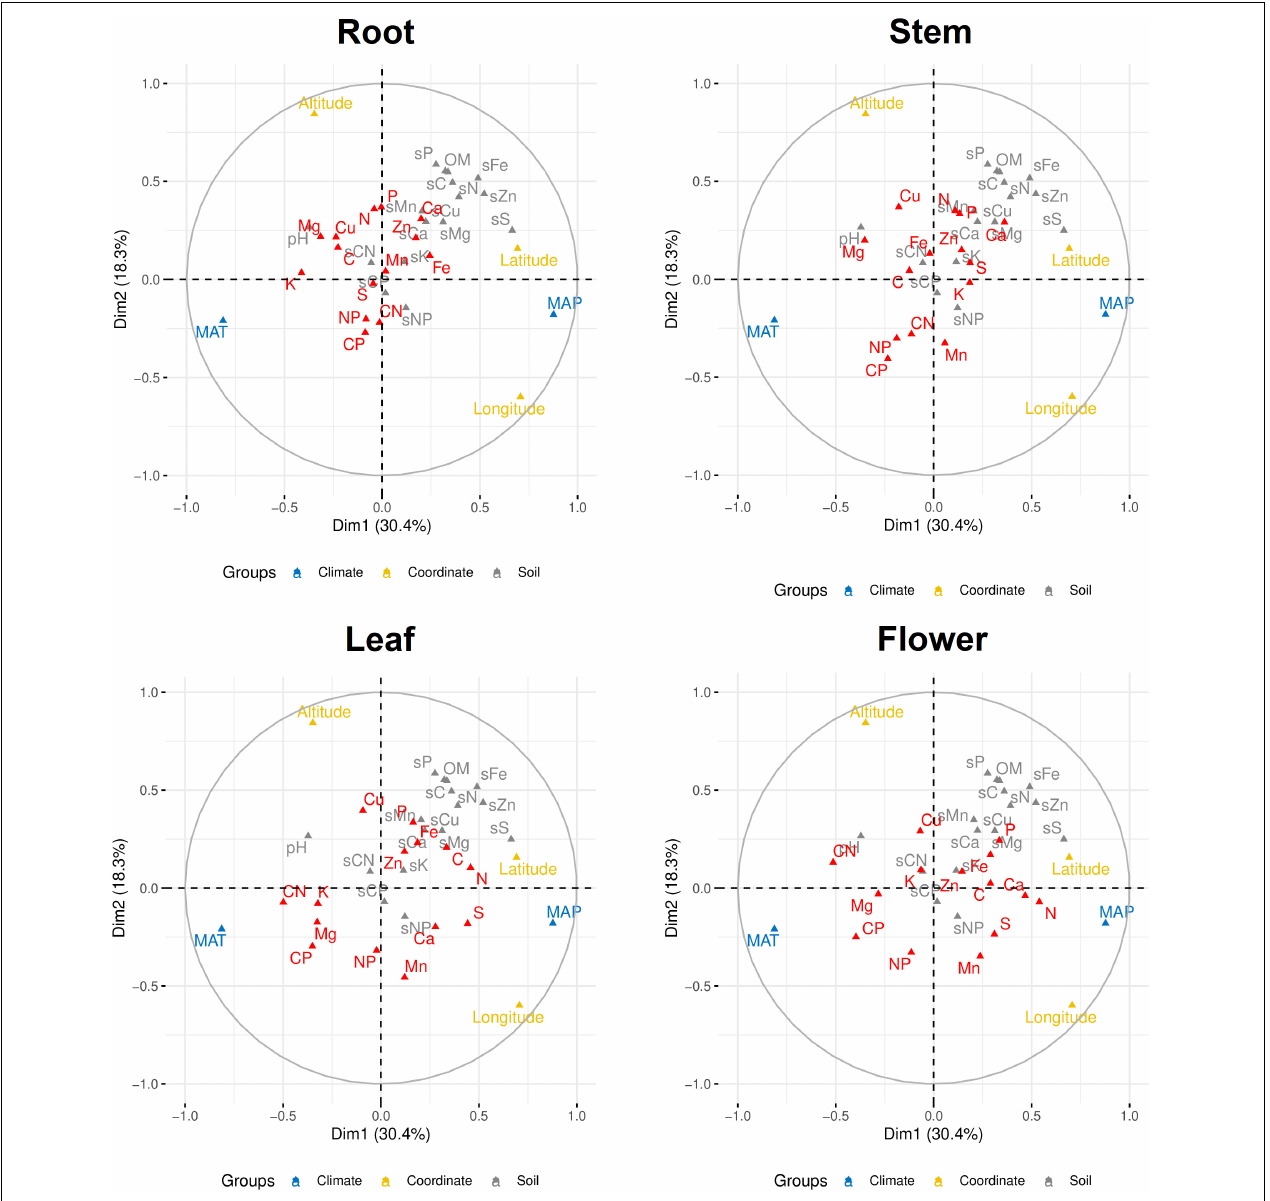
FIGURE 7 | Multiple factor analysis of abiotic environmental factors and multielemental stoichiometry in plant organs. Elements and C:N:P ratios in plants are in red color. MAP, mean annual precipitation; MAT, mean annual temperature; sC, soil carbon; sN, soil nitrogen; sP, soil phosphorus; sK, soil potassium; sCa, soil calcium; sMg, magnesium; sS, soil sulfur; sFe, soil iron; sMn, soil manganese; sCu, soil copper; sZn, soil zinc; sCN, soil C:N ratio; sCP, soil C:P ratio; sNP, soil N:P ratio; OM, soil organic matter, pH, soil pH; CN, plant C:N ratio; CP, plant C:P ratio; NP, plant N:P ratio.